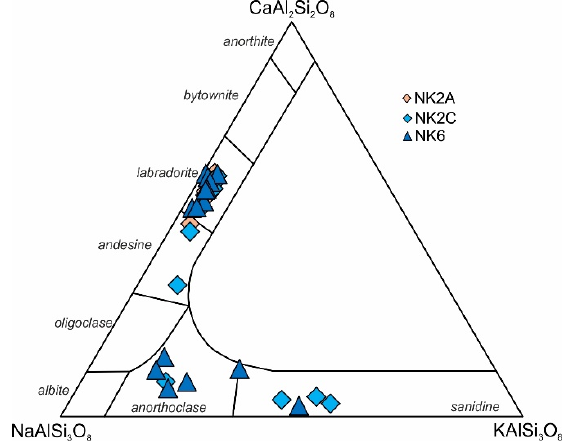
Figure 6. Feldspar compositions observed in the Njimom dykes.